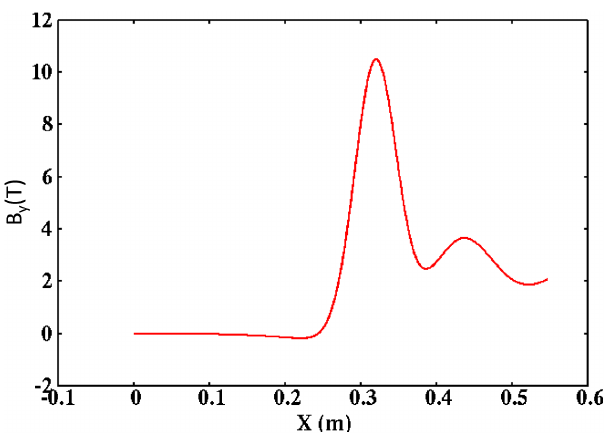
FIG. 13. Vertical magnetic field distribution in the middle plane of the bending magnet